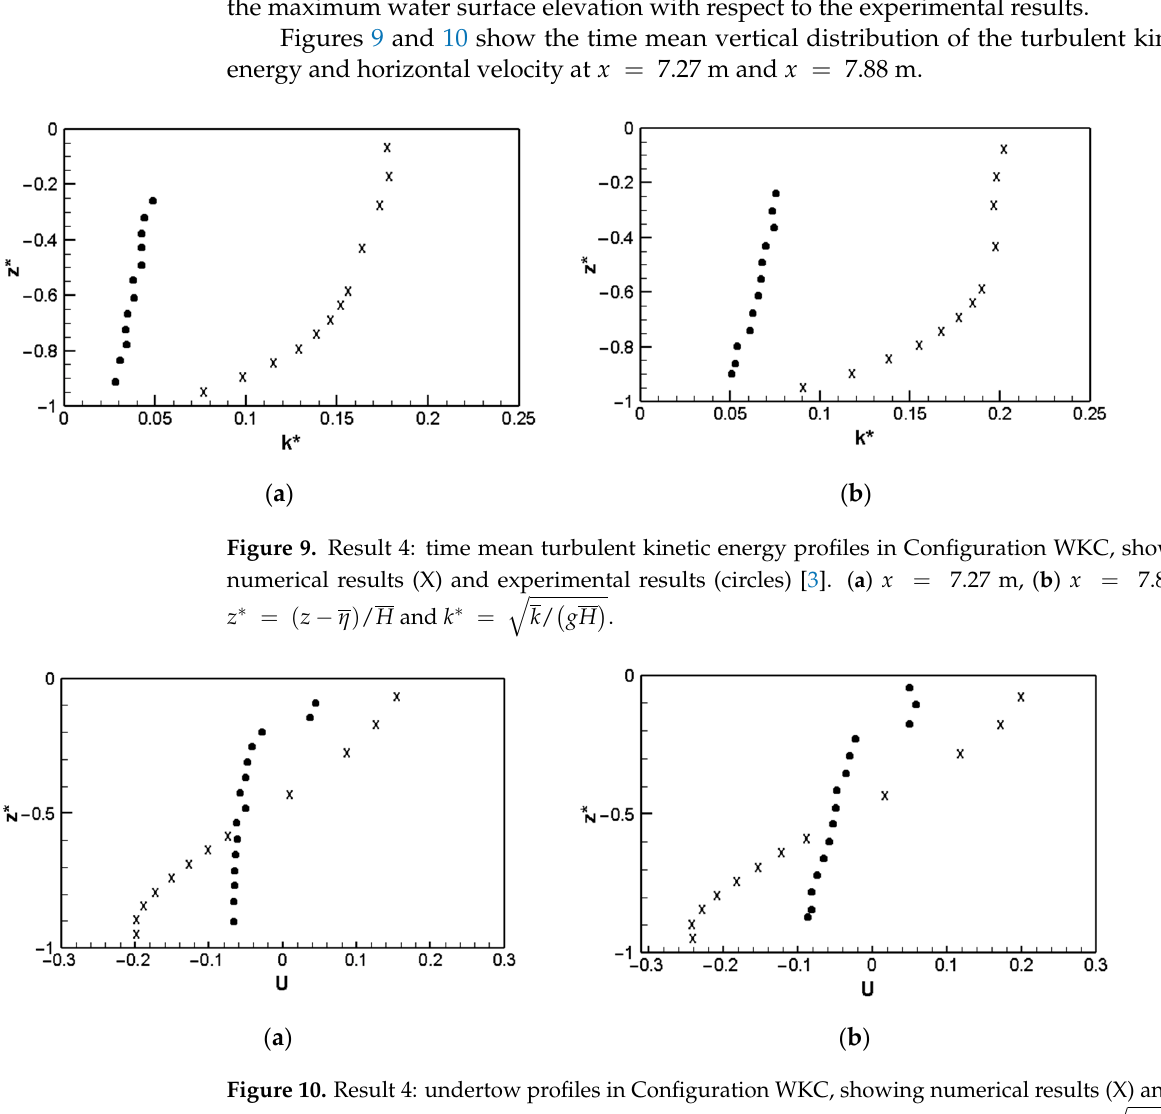
(cid:113) (cid:0) (cid:1) k / gH ;